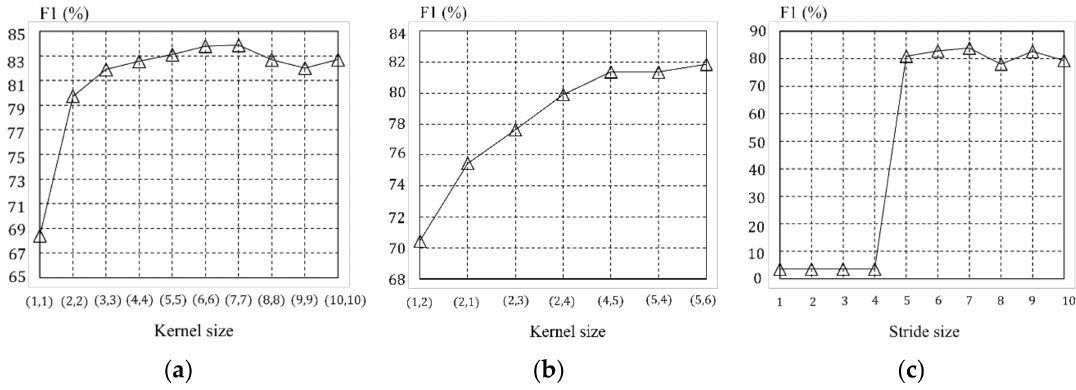
Figure 9. Experiment results with various hyperparameter setting: ( a ) and ( b ) kernel size; ( c ) stride